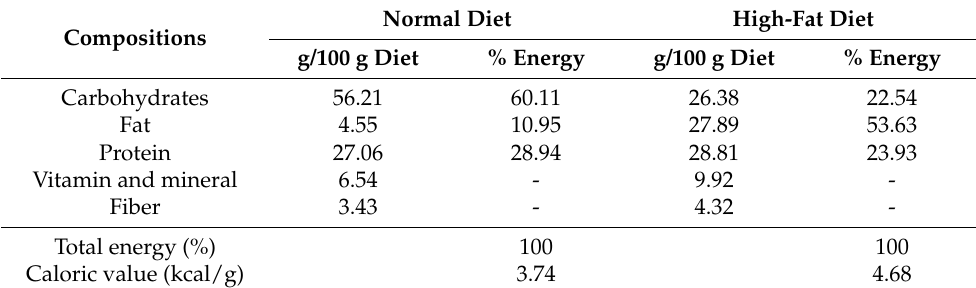
Table A1. Nutritional compositions of the experimental diets.